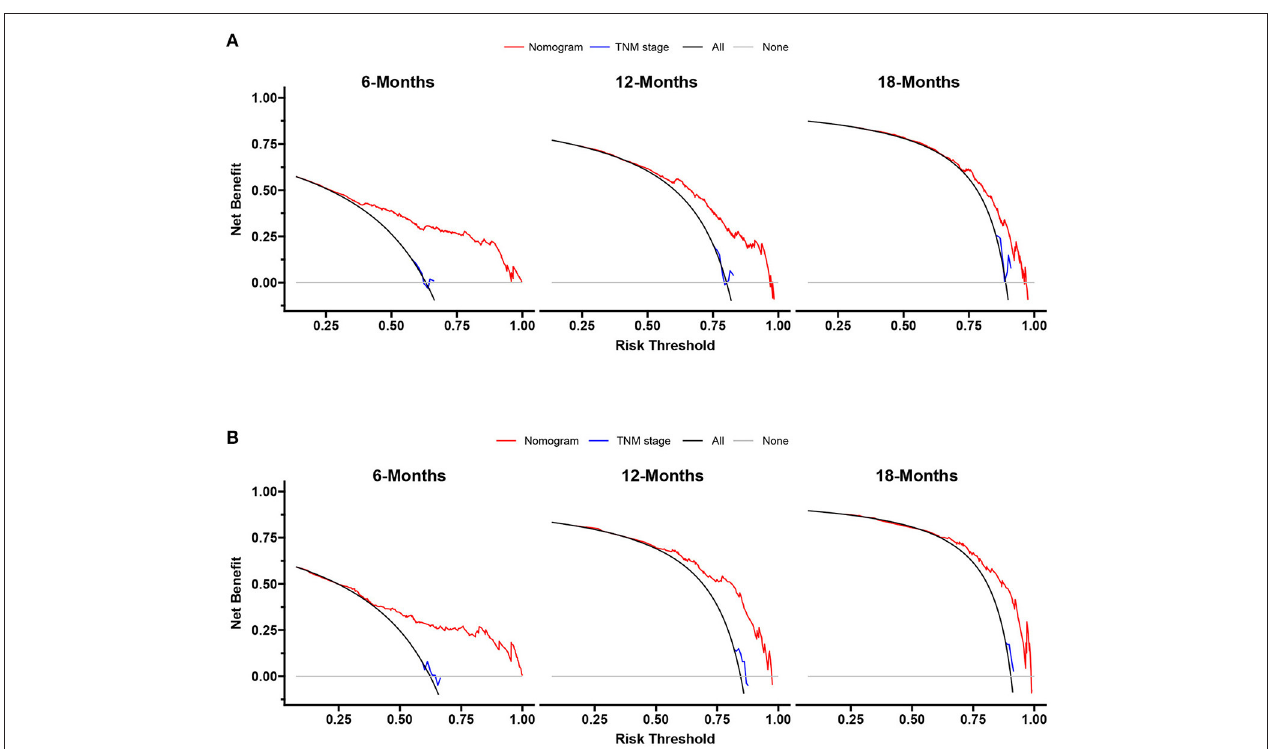
FIGURE 10 | Decision curves of the nomogram and TNM stage for survival prediction of PCLM patients. (A) 6-, 12- and 18-months survival benefit in the training cohort. (B) 6-, 12- and 18-months survival benefit in the verification cohort.